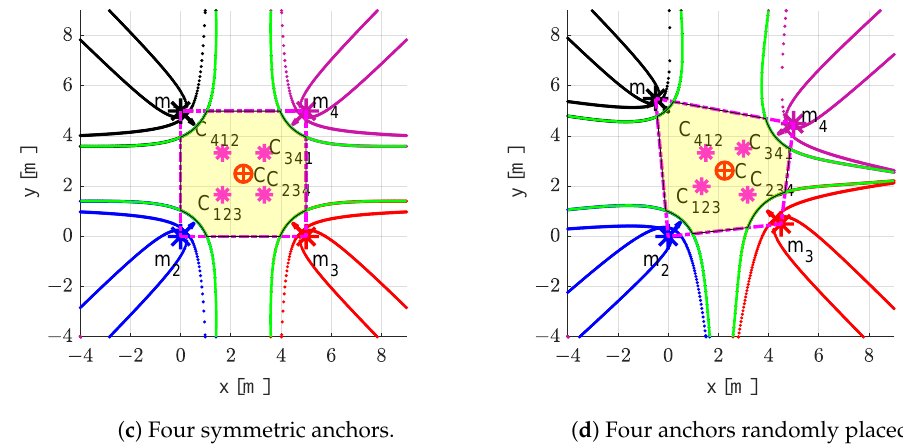
Figure 6. Bifurcation curves, bifurcation envelopes (green line), convex hull of anchors (magenta trapezoid, acceptable precision), and flyable area (yellow shade) for three and four